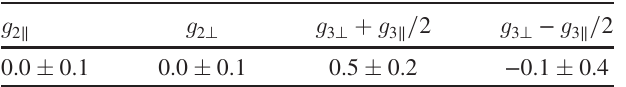
TABLE I. The g-factors in Hamiltonian Eq. (2) which, together with the zero-field splitting 2 D ¼ 70 MHz and g ∥ ≈ g ⊥ ≈ 2 . 0 , describe the GS fine structure of the silicon vacancy ( V 2 center in 4H-SiC) in a magnetic field.